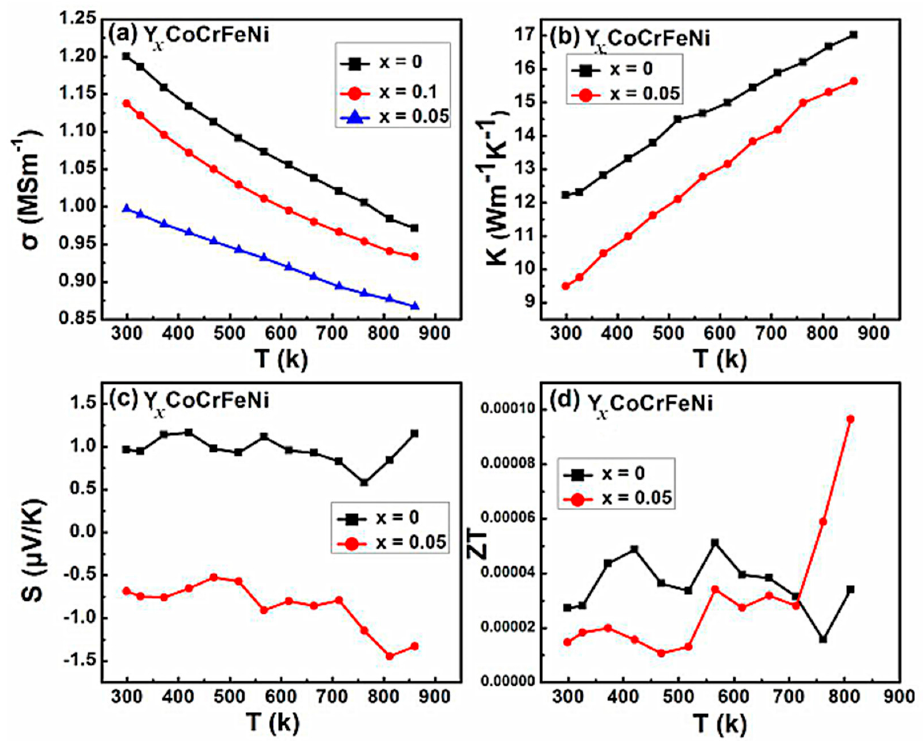
Figure 6. Thermoelectric properties of the Gd x CoCrFeNiCu alloy. ( a ) Electrical conductivity; ( b ) Thermal conductivity; ( c ) Seebeck coefficient; ( d ) Figure of merit, ZT.